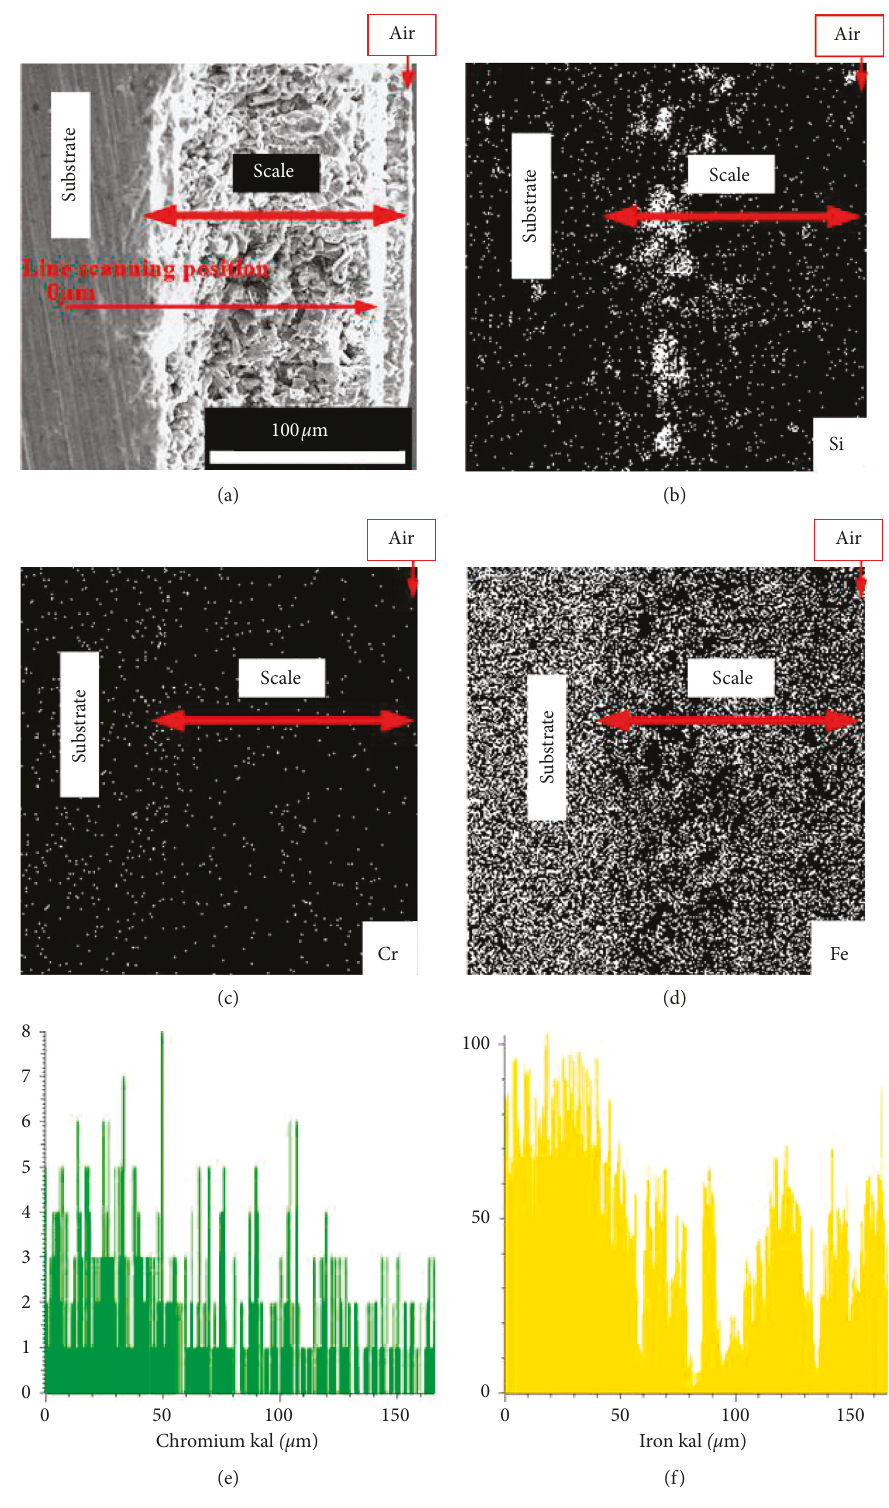
Figure 2: Element distribution on the cross section of the 20CrMnTi uncoated